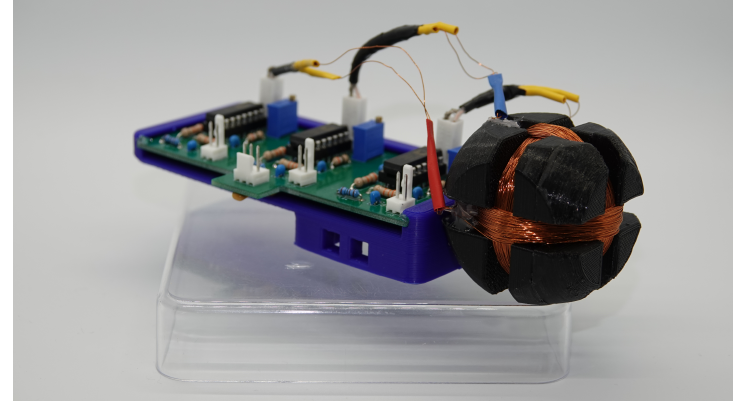
Figure 10. Receiver with the orthogonal aligned coils.